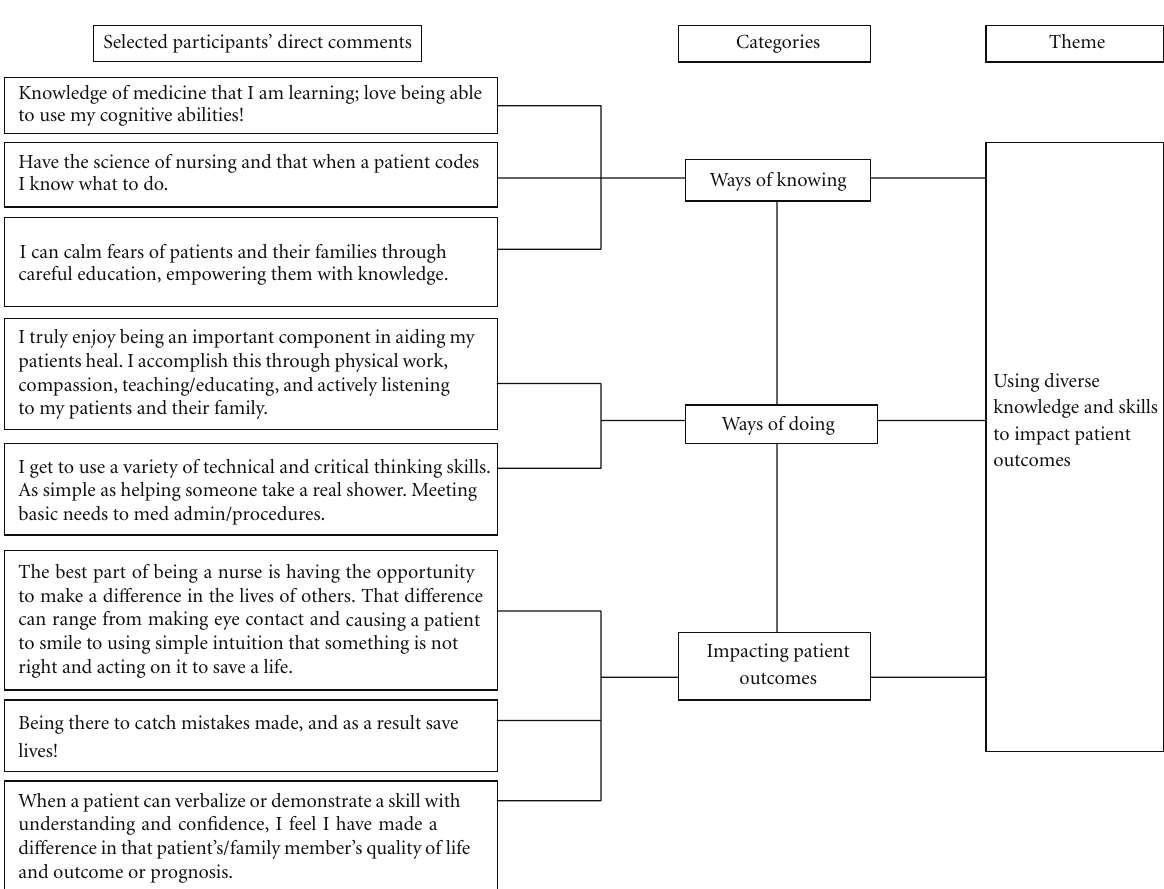
Figure 1: This is an example of a partial dendrogram showing how the respondents’ comments were categorized and used in developing a